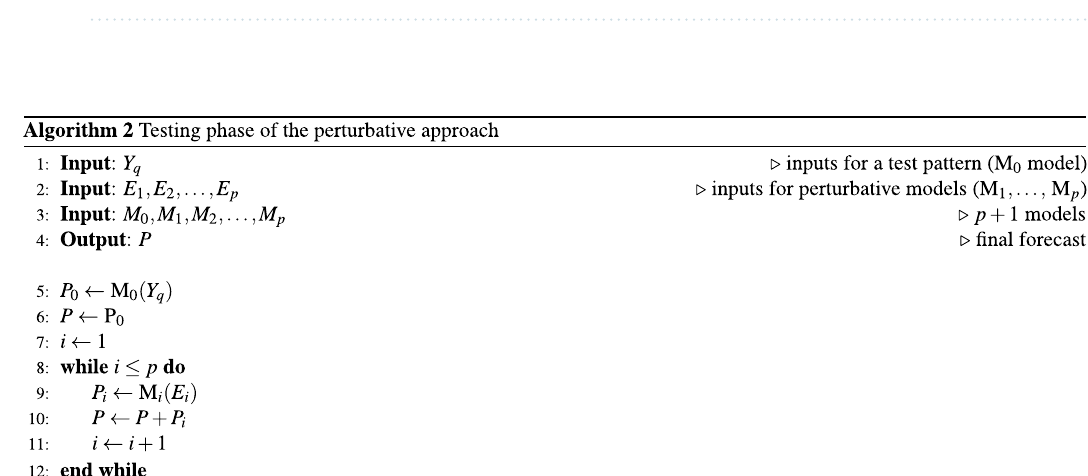
Figure 1. NoLiC training and testing